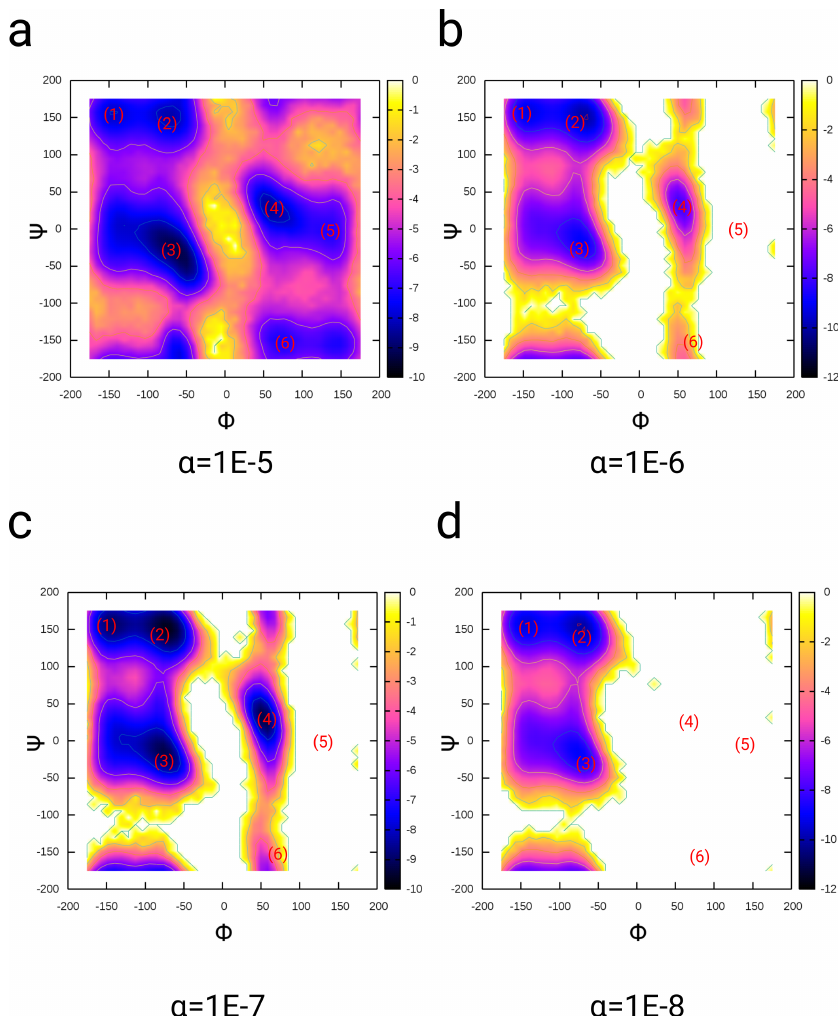
Figure 3. Free energy landscapes of dialanine as a function of dihedral angles Φ and Ψ for different coupling factors α ranging from 10 − 8 to 10 − 5 (panels: ( a – d )). We simulated dialanine at room temperature (300 K) for 50 ns using the PMF-enriched sampling method ( (cid:101) = 20). The partitions are in agreement with 1 µ s MD trajectories [83]. For the determination of the acceleration of the PMF-enriched methodology, we determined escape times τ of the Φ -angle (the transition time for Φ to change its value from < 0 to values > 0). We observe for α = 10 − 5 , τ = 282.3 ps; for α = 10 − 6 , τ = 2586.9 ps; for α = 10 − 7 , τ = 3244.4 ps; and for α = 10 − 8 , τ = ∞ (no transition). The relative acceleration n of the PMF-enriched method for α = 10 − 5 equals a factor of n = 151.2 (MD: τ = 42696.7 ps [83]); for α = 10 − 6 , n = 16.5; and for α = 10 − 7 , n = 13.1. The colored bar in each of the free energy landscapes corresponds to energy values in units of k B T